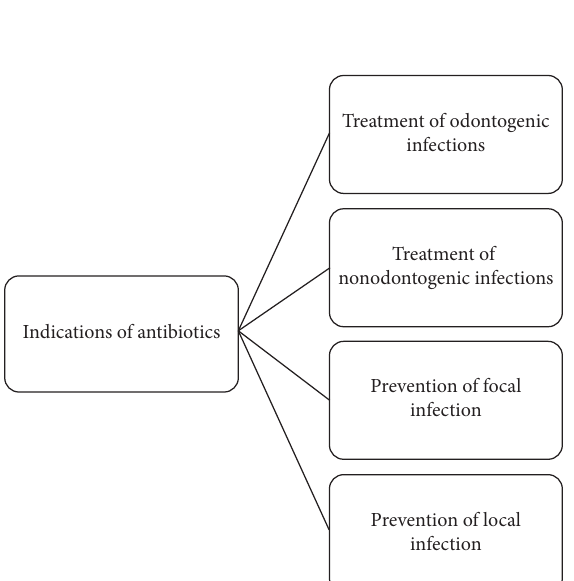
Figure 1: The most commonly used antibiotics in